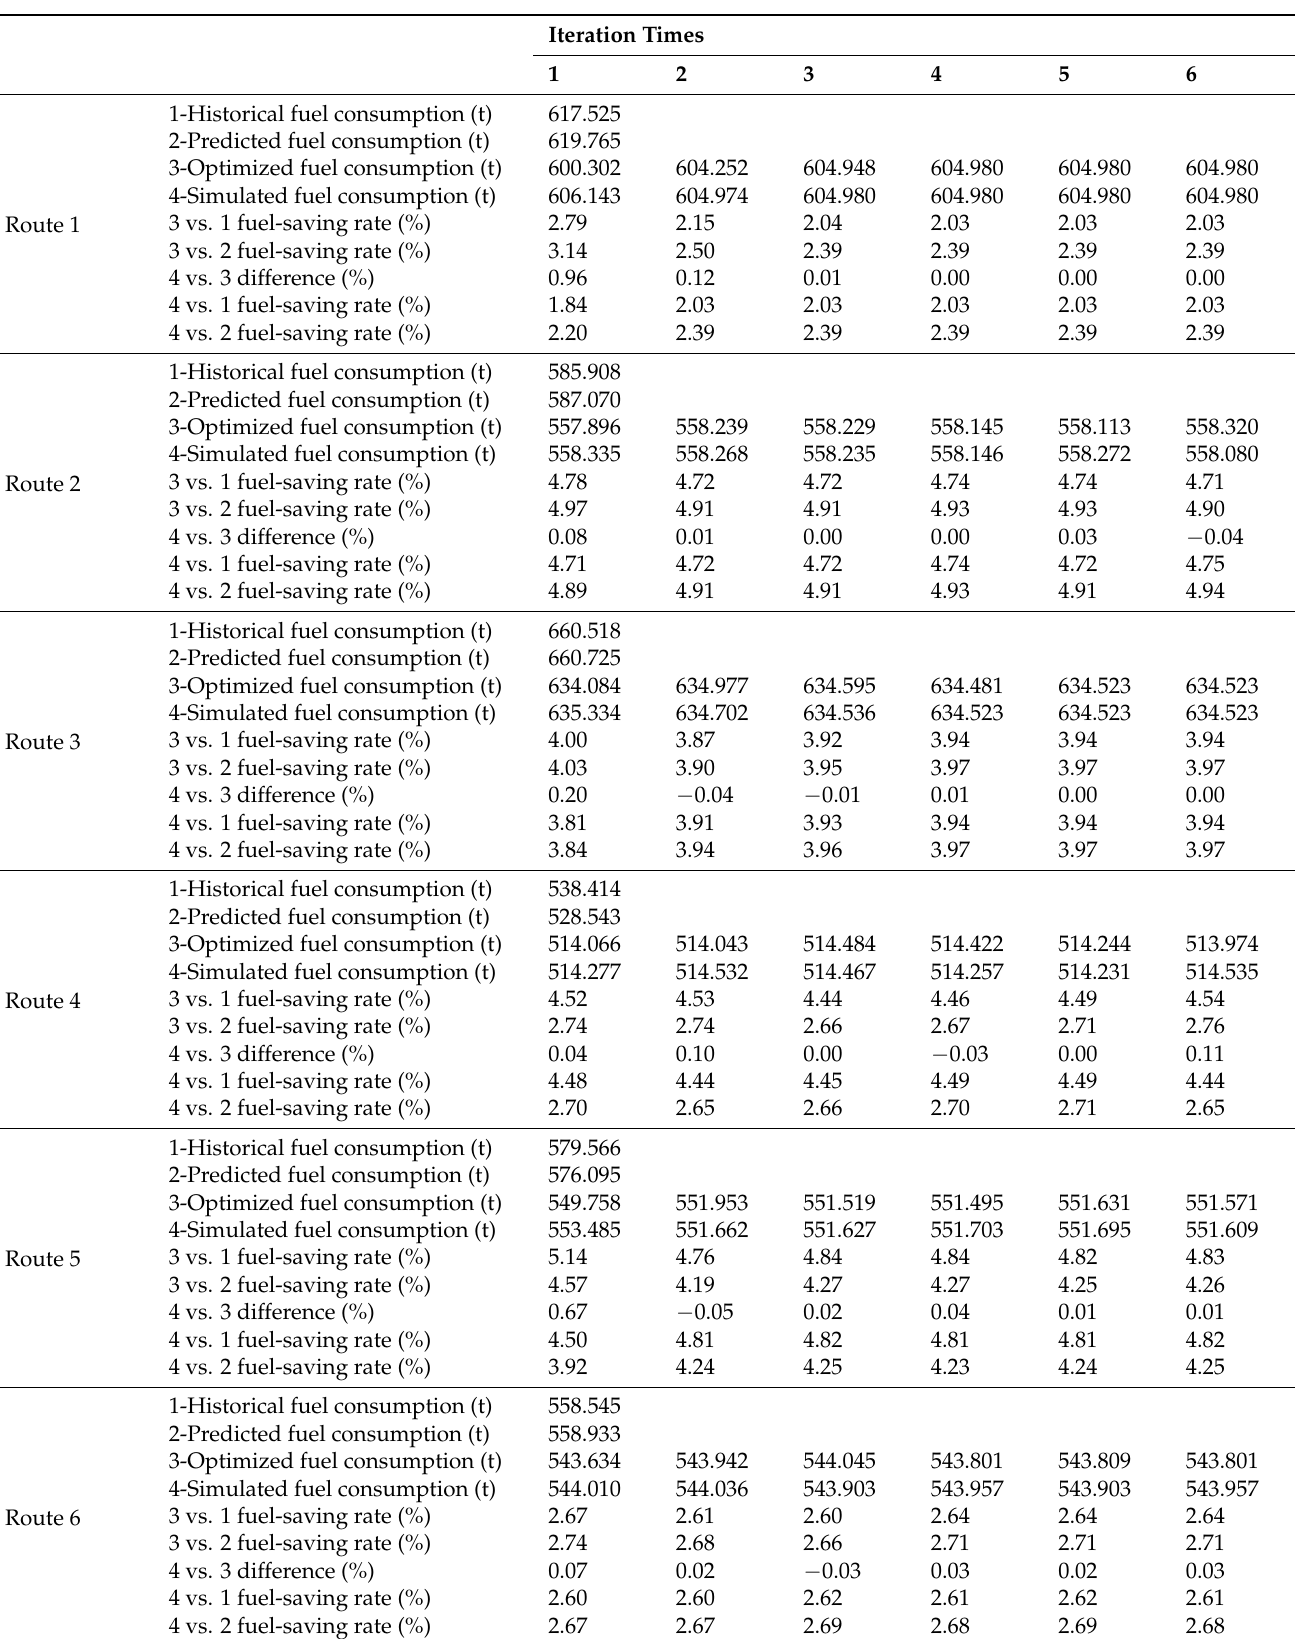
Table 6. Comparison results of fuel consumption under single trim and draft